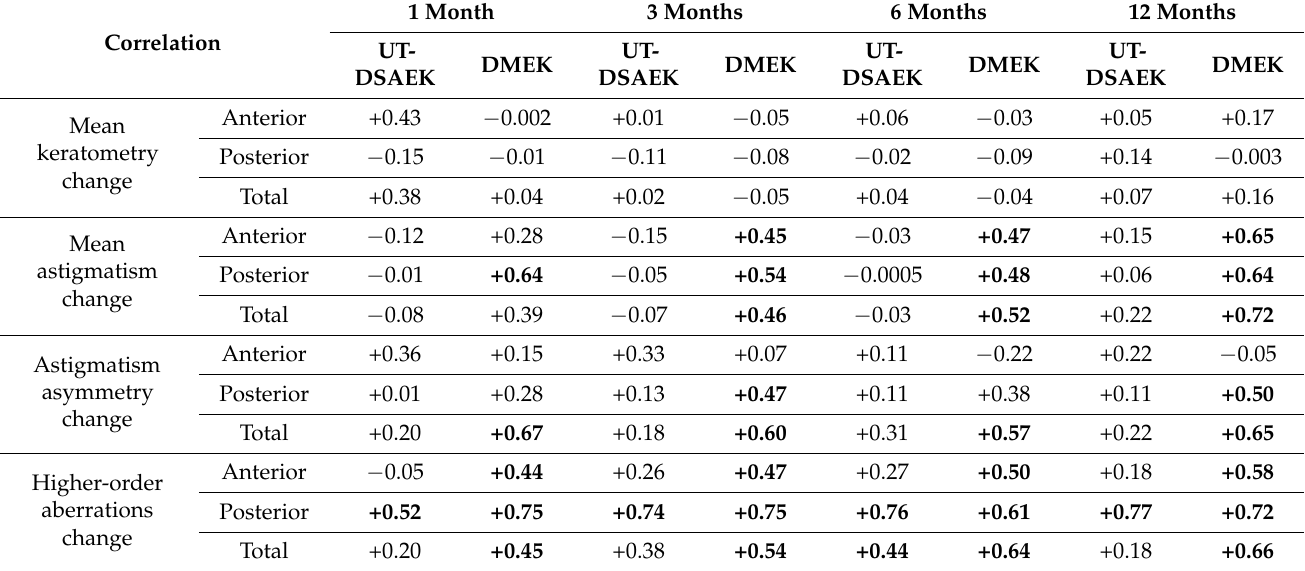
Table 5. The correlations between the central corneal thickness (CCT) change and changes in the magnitudes of the keratometry, astigmatism, astigmatism asymmetry and higher-order aberrations that were obtained in 3 mm optical zones (OZs) in the eyes after Descemet membrane endothelial keratoplasty (DMEK) and ultrathin Descemet stripping automated endothelial keratoplasty (UT-DSAEK) procedures. Correlations were calculated for 4 consecutive time points, i.e., 1, 3, 6 and 12 months after the surgery. Statistically significant values are shown in